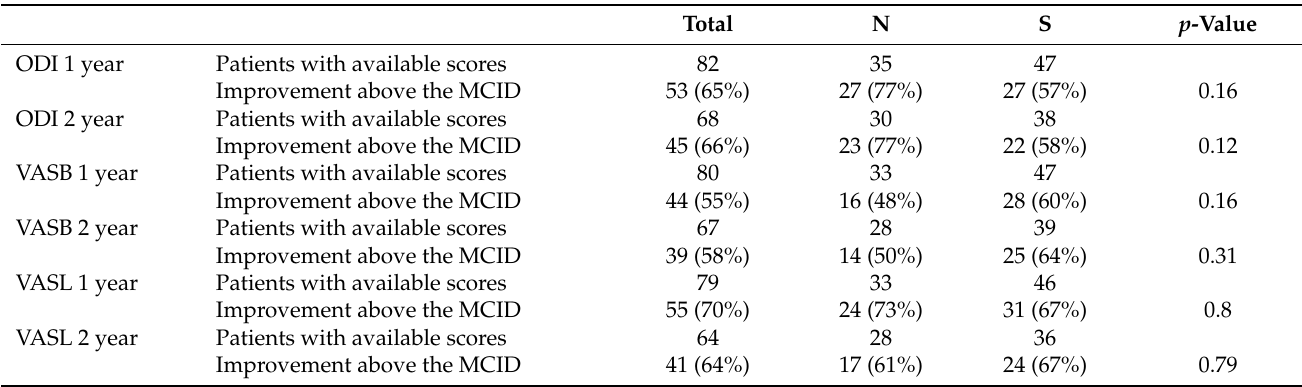
Table 4. Proportions of patients from each group with improvement exceeding the MCID in each of the patient reported outcome